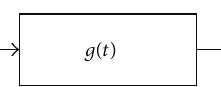
Figure 2: Schematic of linear, time-invariant system representing test model-accelerometer balance